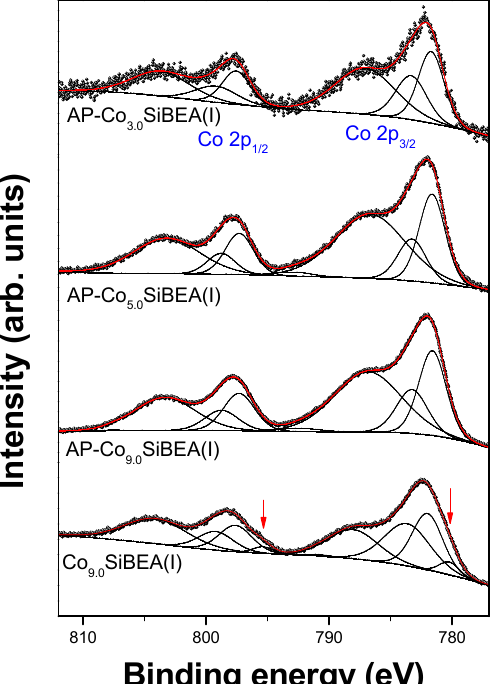
Figure 8. Co 2p XPS spectra of Co x SiBEA (pH = 3.0–9.0). Red arrows mark a low-BE component which is not seen in as received samples.